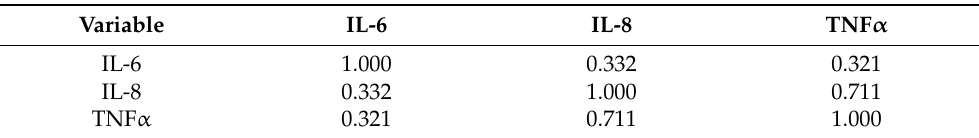
Table 5. The correlations between IL-6, IL-8, and TNF- α , presented as the Spearman’s ranges‚ r’ correlation coefficient. p < 0.05 for all presented